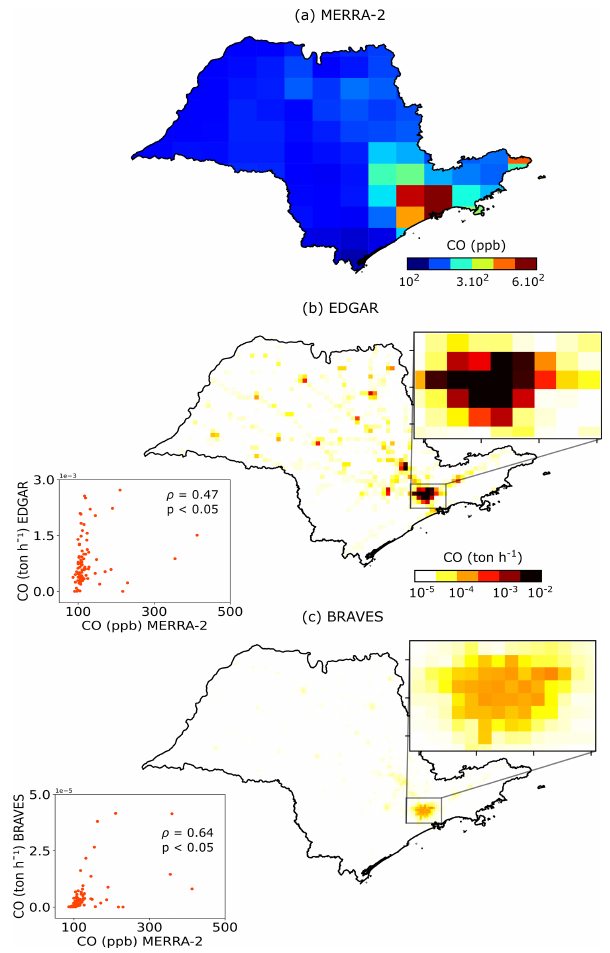
Figure 10. CO spatial distribution provided by (a) MERRA-2, (b) EDGAR, and (c) BRAVES. Scatter plots of CO vehicle emission and CO hourly surface concentrations in SP on 1 January 2015 at